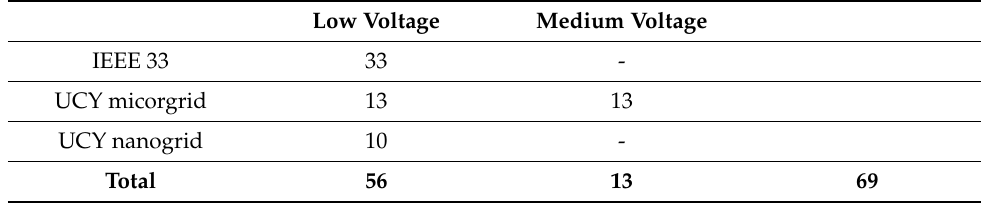
Table 4. Number of buses used in the investigated